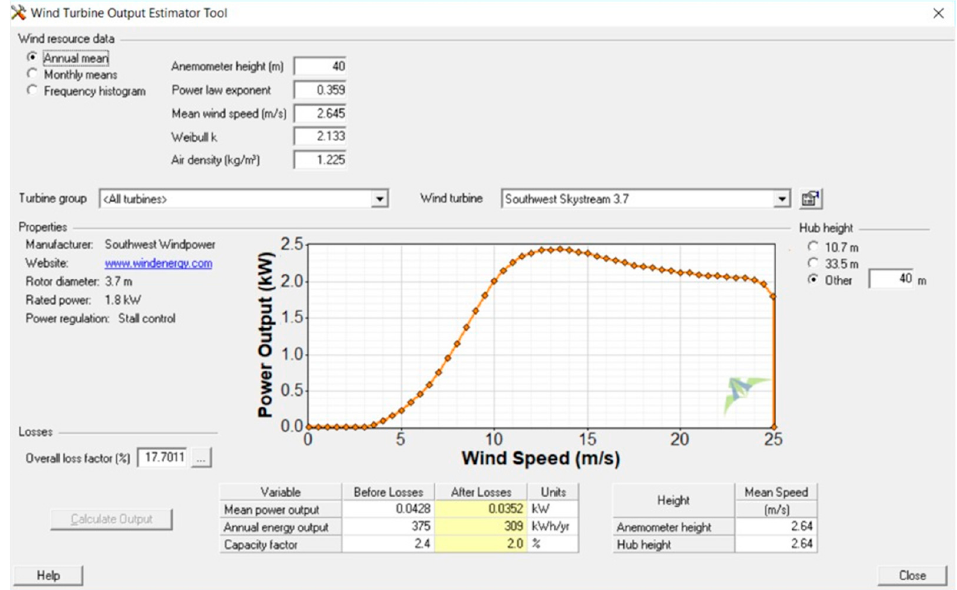
Figure 13. Energy annual calculation estimation for the SWT. Source: our calculations with Windographer ® .